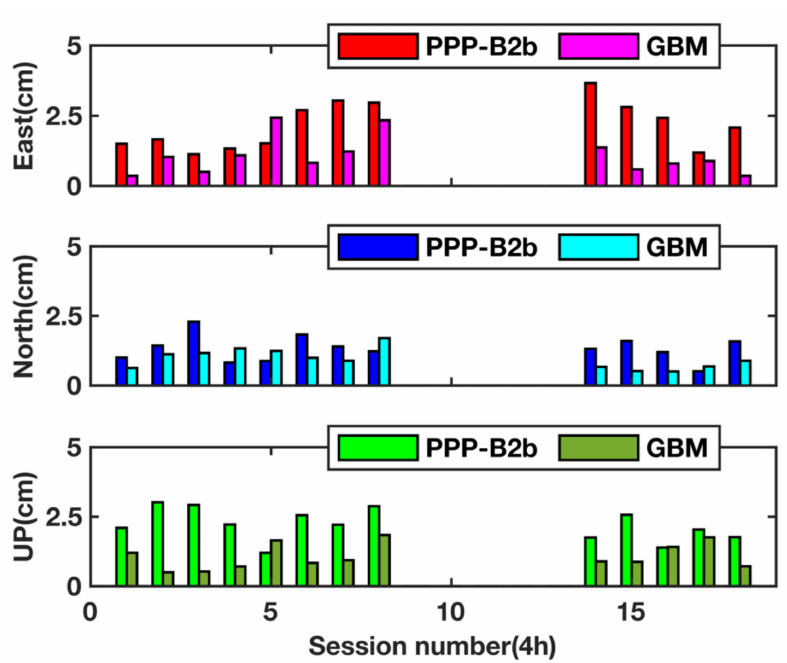
Figure 10. Positioning accuracy of static PPP with different data sessions at KUN1